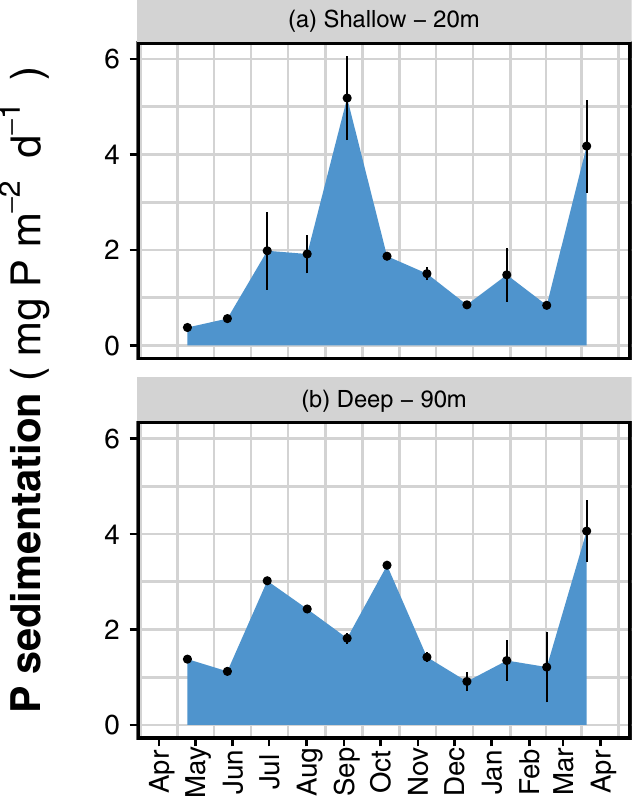
Figure 3. Downward P flux rates determined from total P in settled material caught in automatic sediment traps positioned at 20 m ( a ) and 90 m depth ( b ) at station B from April 2016 to April 2017. Individual collector bottles received material over 31-day periods. Bars indicate ranges from duplicate collector bottles. Total sedimentation was 396 and 375 g dry weight m −2 year −1 for traps in 20 and 90 m, respectively. Additional data can be found in Supplementary Table